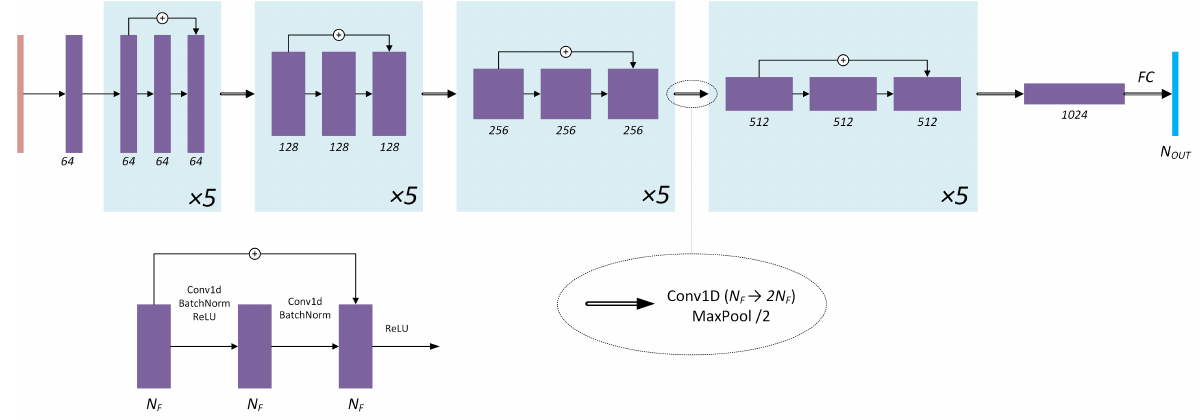
Figure 6. RegParamNet